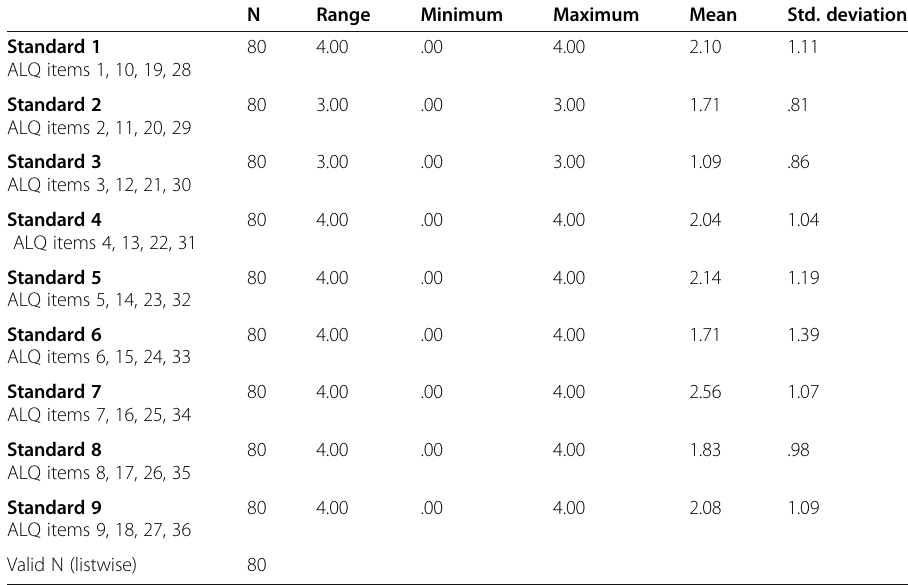
Table 3 Total questionnaire mean for each standard N Range